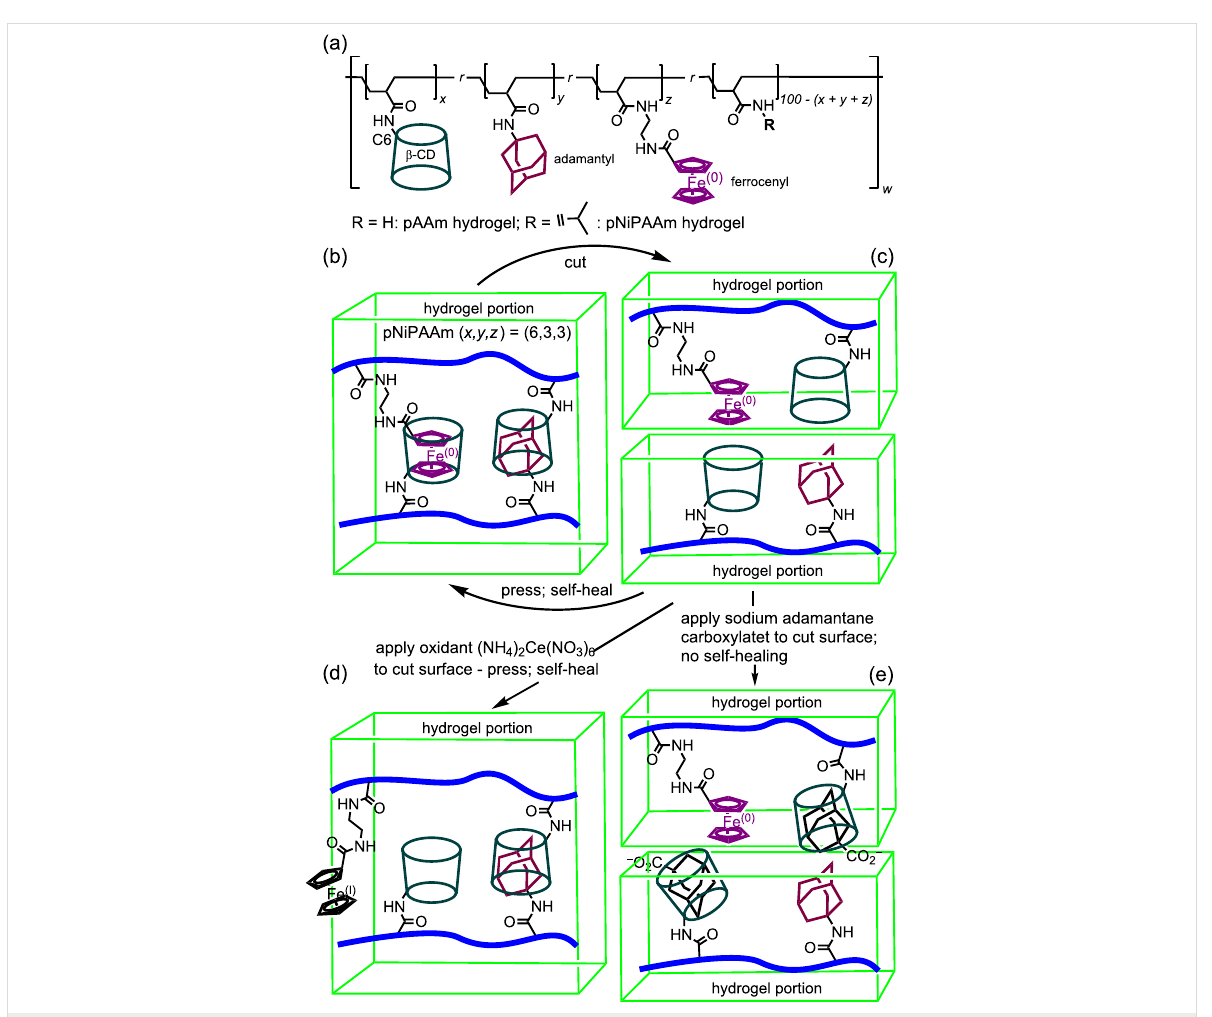
Figure 24: (a) The β -CD, adamantyl and ferrocenyl substituted pAAm and pNiPAAM polymers. (b) The β -CD, adamantyl and ferrocenyl substituted pNiPAAM hydrogel where the substituent mol % ratio x : y : z is 6:3:3. (c) Cutting of a hydrogel cube and self-healing of the two halves after pressing together. (d) Oxidation of the ferrocenyl (Fe(0)) substituent to positively charged ferrocenium (Fe(I)) through oxidation with (NH 4 ) 2 Ce(NO 3 ) 6 on the surfaces of the halves followed by pressing and self-healing. (e) Addition of sodium adamantane carboxylate to the surfaces of the halves results in competitive host–guest complexation and an absence of self-healing